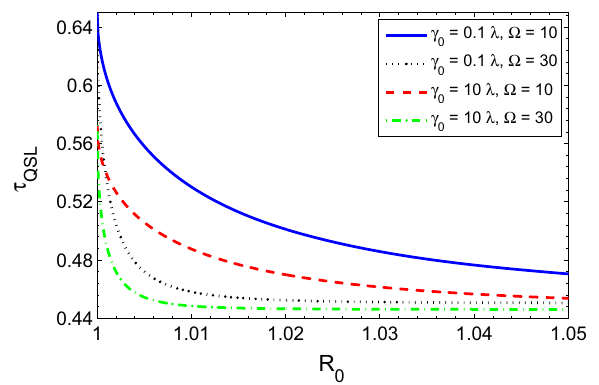
Fig. 7 The QSL-time for the Ohmic-like dephasing model as a func- tion of the initial time parameter τ for sub-Ohmic environment. The Ohmicity parameter is s = 0 . 5 and Ω =